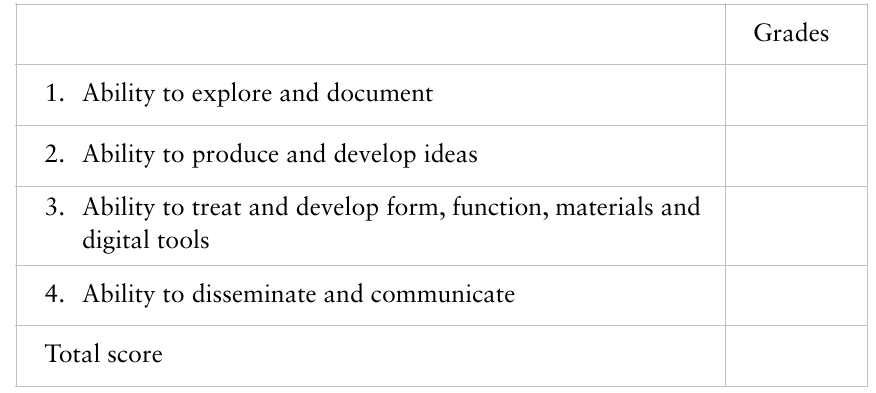
Table 3. Illustration of scoring mechanism for ranking